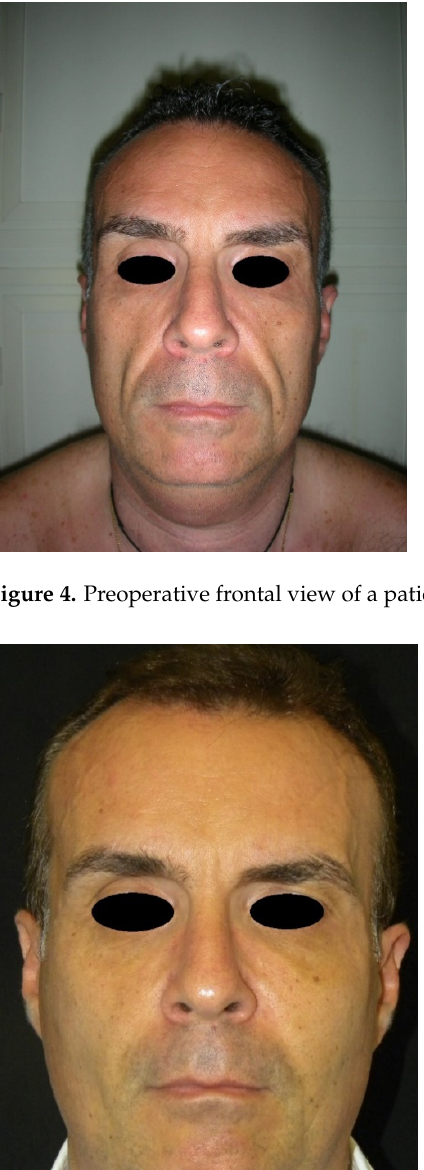
Figure 6. Frontal view of a patient presenting facial wasting and submental fullness (the same patient shown in Figure 4) treated with CaHA and DCA injection, at 8 months and 3 months fol- low-up respectively. A total of 286 sessions of filler injections were performed between 2008 and 2020 in this patient population. Follow-up ranged between 6 months and 9 years; follow up in patients receiving HA, CaHA and DCA was shorter compared to those injected with polyacrylamide hydrogel, respectively 1.2 years and 2.8 years on average.